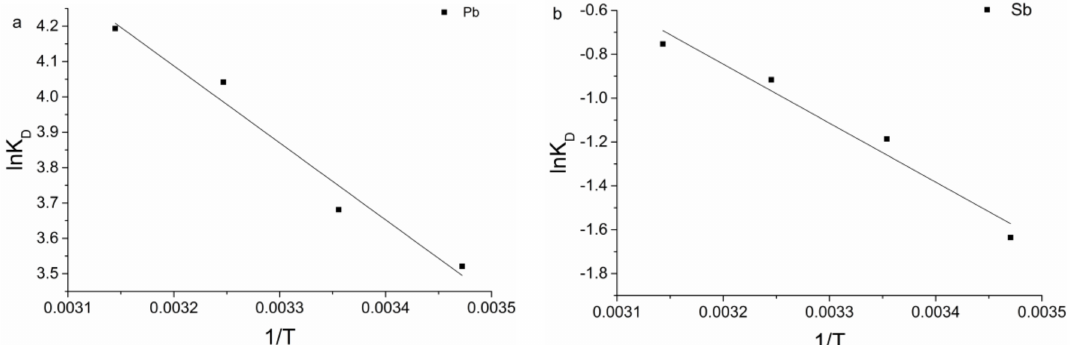
Figure 5. Plots of ln K D vs. 1/ T for the estimate of thermodynamic parameters for biosorption on B. subtilis biomass ( a ) for Pb(II) and ( b ) for